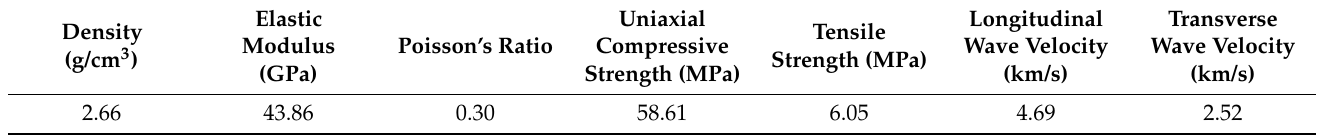
Table 1. The physical parameters of the rock specimens.